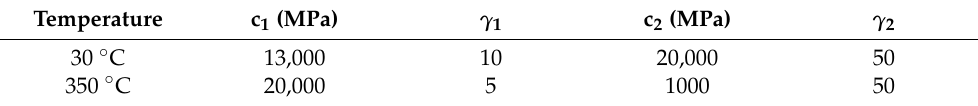
Table 5. Material parameters of Chaboche model at different temperatures of TA16. Temperature c 1